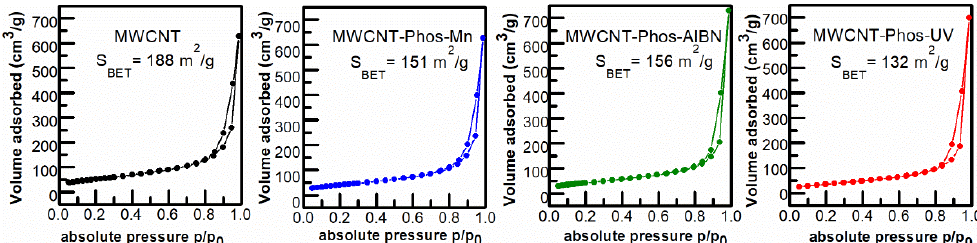
Figure 8. N 2 adsorption–desorption isotherms and corresponding surface area of pristine and functionalized MWCNTs.